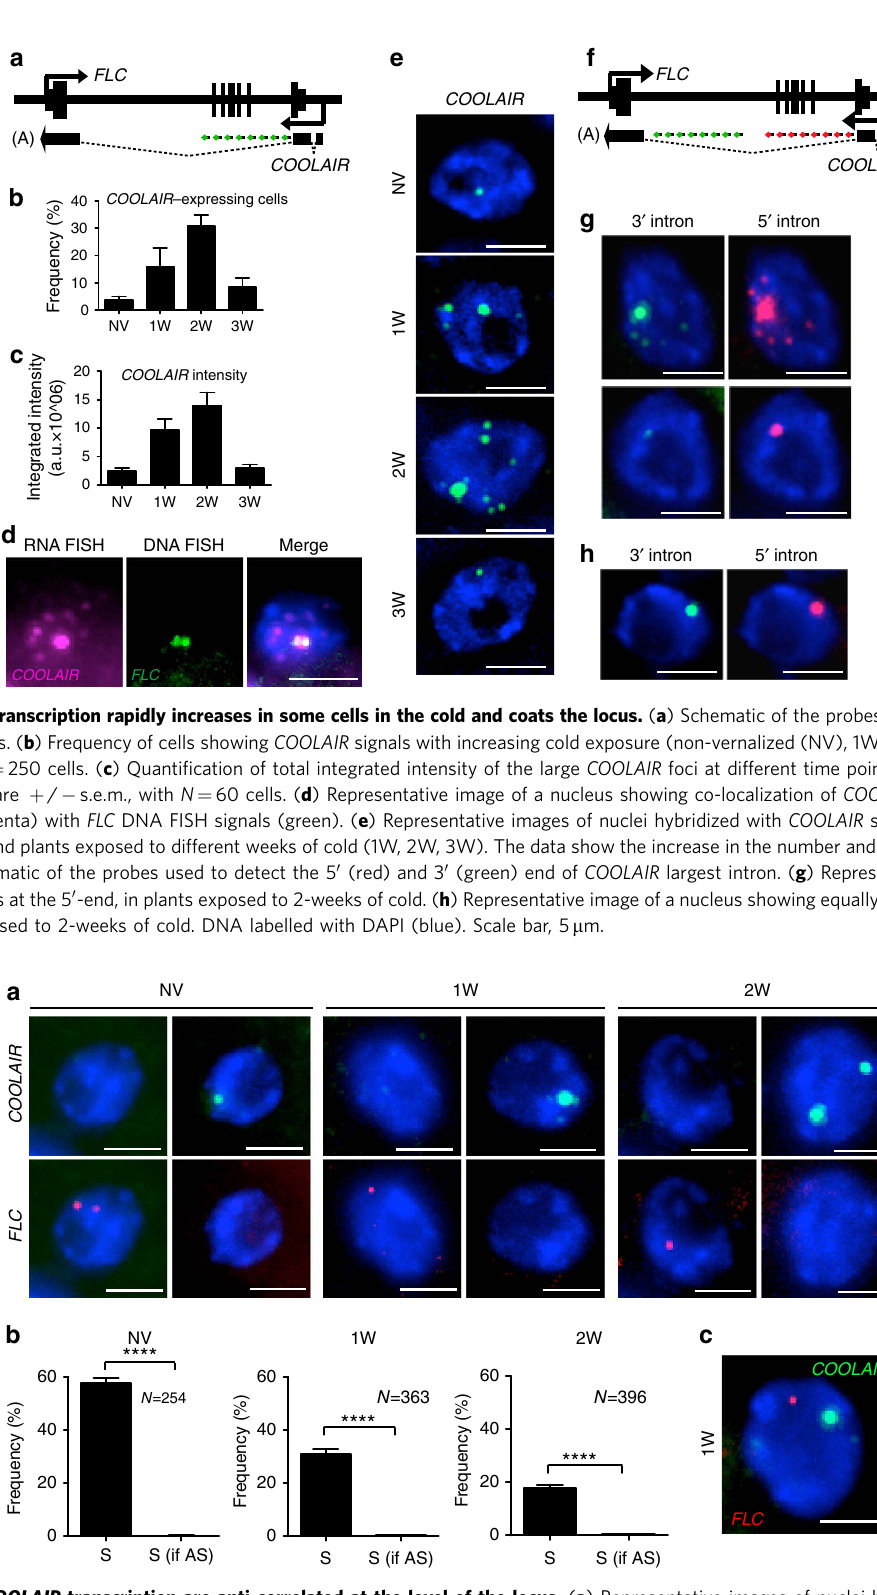
Figure 3 | FLC and COOLAIR transcription are anti-correlated at the level of the locus. ( a ) Representative images of nuclei hybridized with intronic smFISH probes for COOLAIR (green) and FLC (red) showing mutually exclusive transcription. Plants were given no cold (non-vernalized plants (NV)) or different weeks of cold (1W, 2W). DNA labelled with DAPI (blue). Scale bar, 5 m m. ( b ) Frequency of loci transcribing FLC , when COOLAIR is not present (S) or is detectable at the same locus (S if AS). FLC and COOLAIR transcription are anti-correlated at the level of the gene throughout all time points analysed (NV, 1W, 2W). N ¼ number of cells analysed. All error bars are þ / (cid:2) s.e.m. ( c ) Representative image of a nucleus hybridized with intronic smFISH probes against non-spliced COOLAIR (green) and FLC (red) in plants exposed to 1-week cold (1W), showing transcription of FLC and COOLAIR from different alleles in the same cell. Scale bar, 5 m